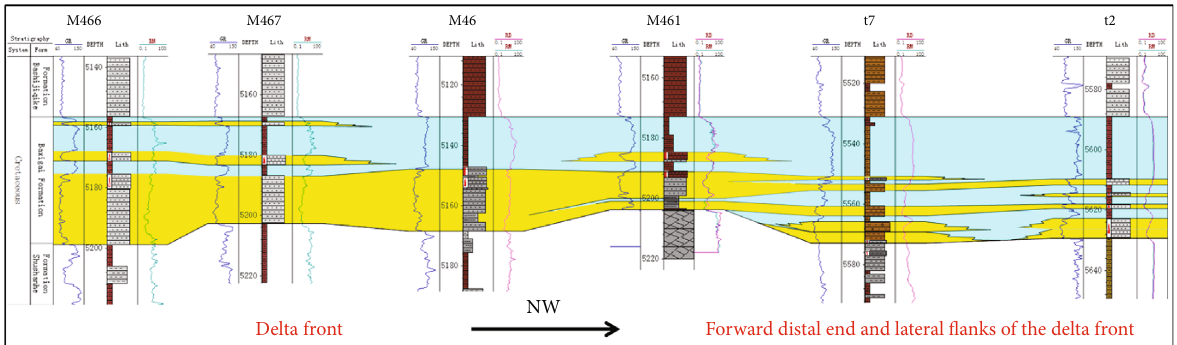
Figure 17: Sand correlation pro fi le of the Cretaceous Baxigai Formation in the Yingmaili area, the western Tabei